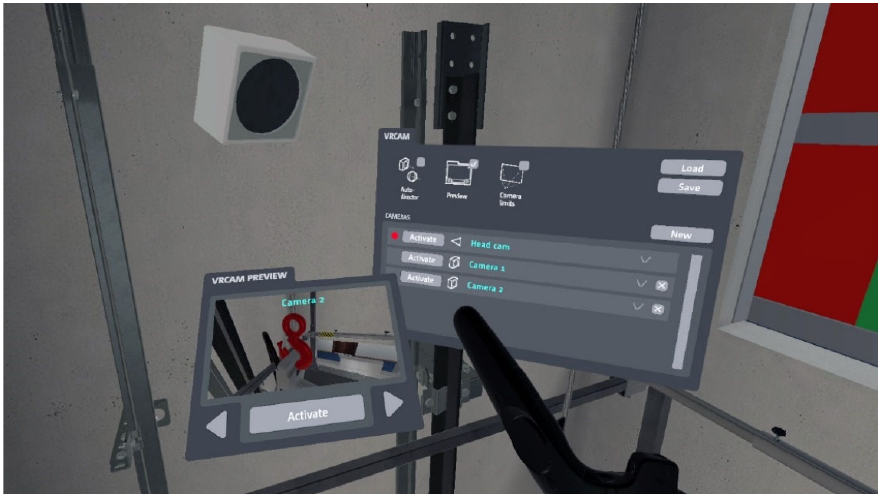
Figure 2. Virtual camera tools inside a virtual elevator shaft. Using the VRCAM menu, the pre ‐ senter can create a set of virtual cameras (white box) and save or load the set. They can preview and activate the view from each camera using a preview window attached to their VR controller (VRCAM PREVIEW). The first ‐ person view was captured from a stabilized virtual camera at ‐ tached to the presenter’s head (headcam).